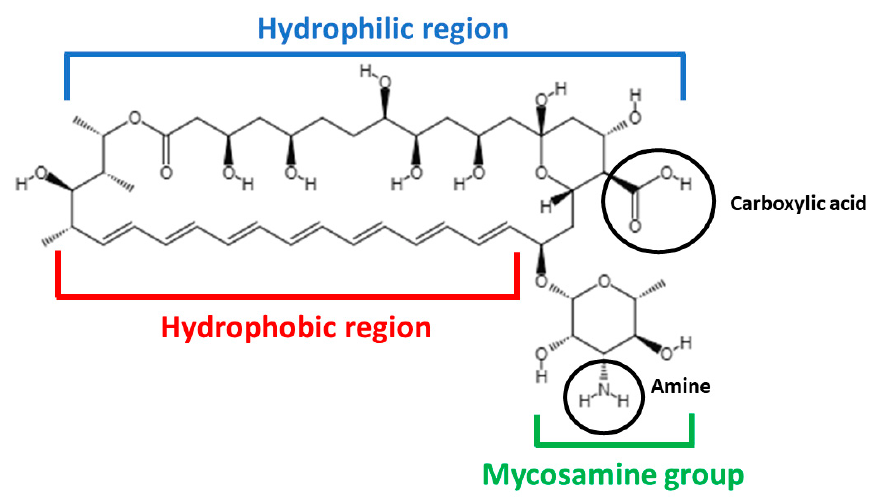
Figure 1. Chemical structure of AmB.